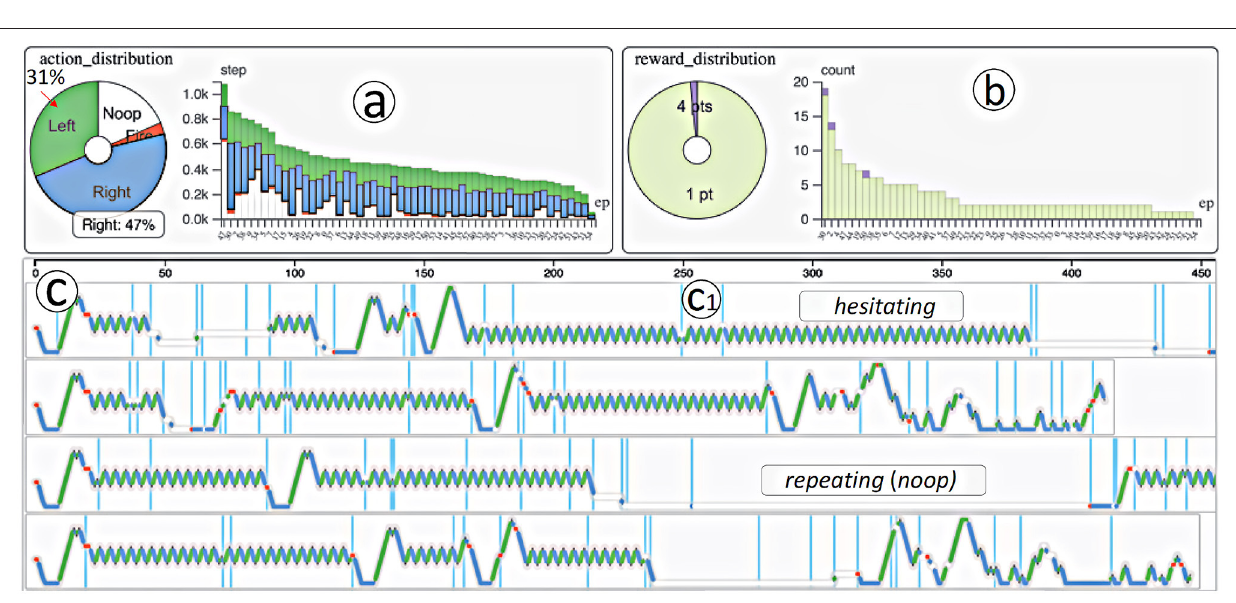
FIGURE 6 | Example visualizations from DQNVis, showing (a,b) episode duration, and (c) actions taken over time and how experts identified these as “hesitating” and “repeating” behaviors which were non-optimal (from Wang et al., 2018, p. 294, reproduced with